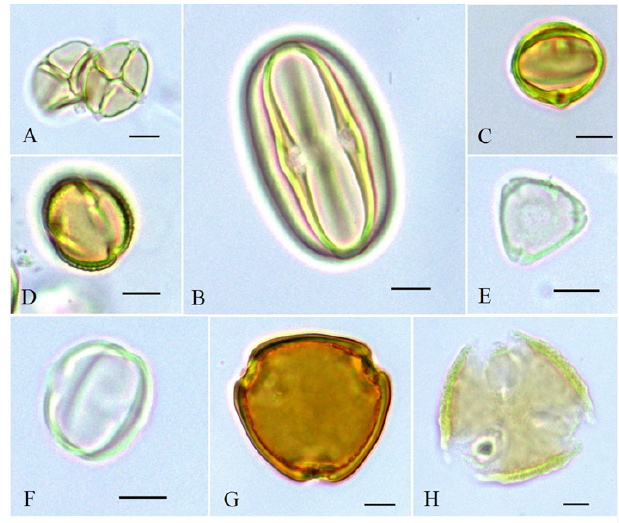
Fig 2 . Photomicrographs of pollen types observed in food pots of (C) Mouriri guianensis , (D) Doliocarpus , (E) Myrcia obtusa , (F) Comolia lythrarioides , (G) Humiria balsamifera , and (H)